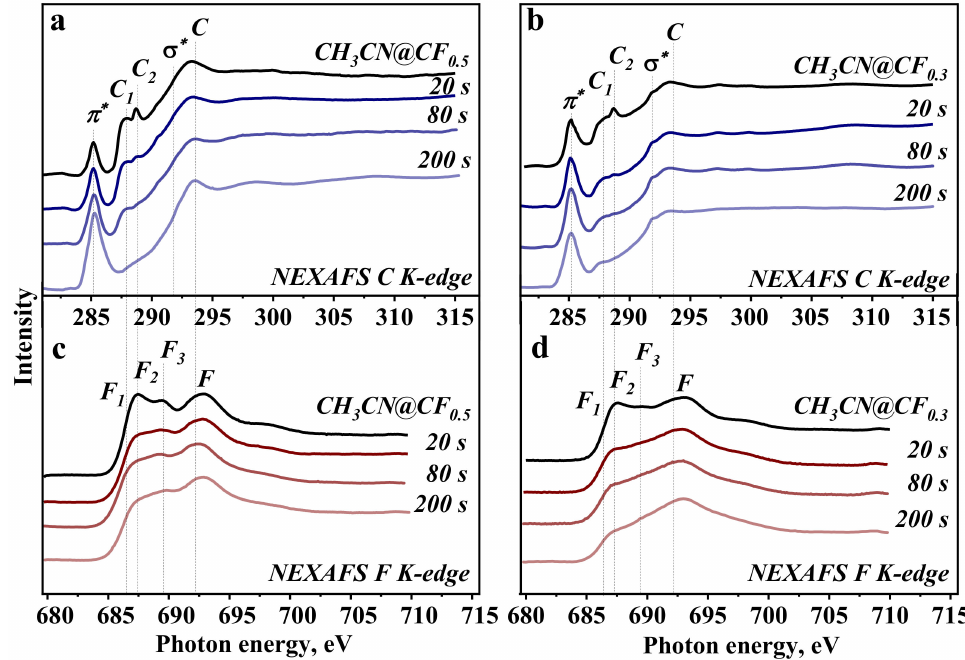
Figure 2. NEXAFS C K-edge ( a , b ) and F K-edge ( c , d ) spectra of CH 3 CN@CF 0.5 ( a , c ) and CH 3 CN@CF 0.3 ( b , d ) before (upper curves) and after irradiation by white beam for 20 s, 80 s, and 200